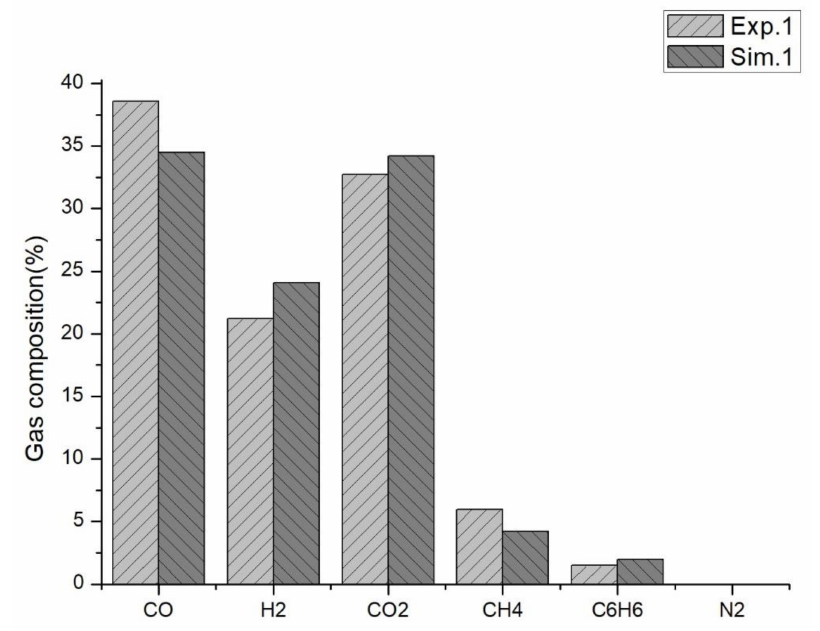
Figure 3. Syngas distribution comparison in case 1 (Steam: 0.76 kg / h, Air: 2.18 m 3 /